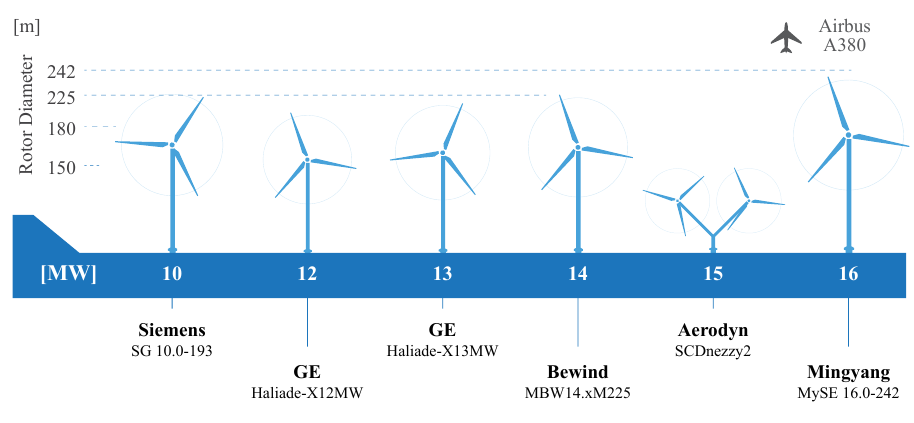
Figure 1. Multi-MW WT